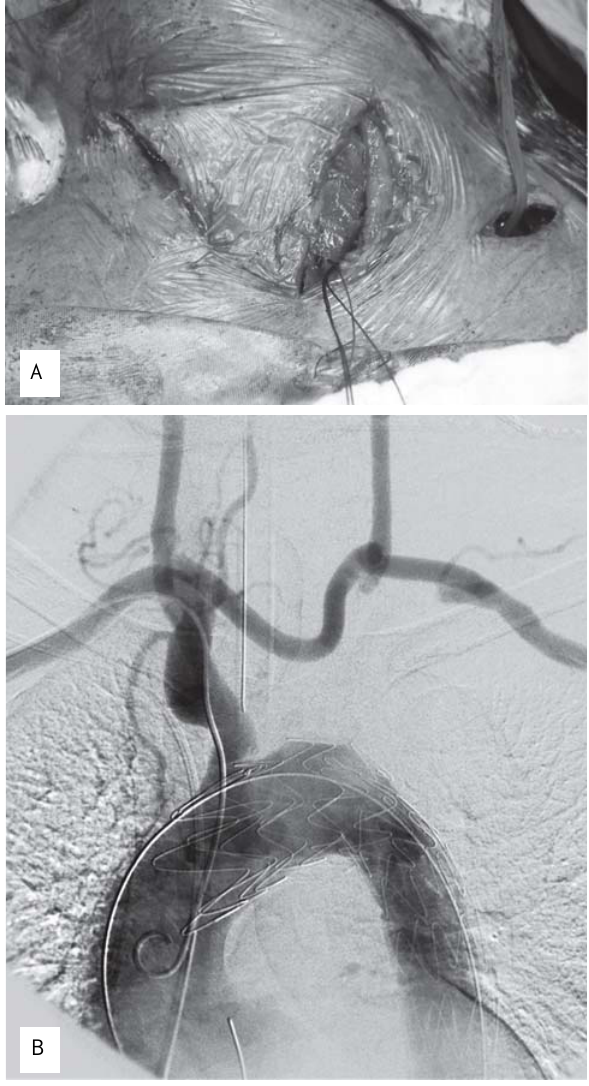
Fig. 3 – A: Paciente nº 8, portadora de dissecção aórtica acometendo a origem da artéria carótida comum esquerda. A: aspecto